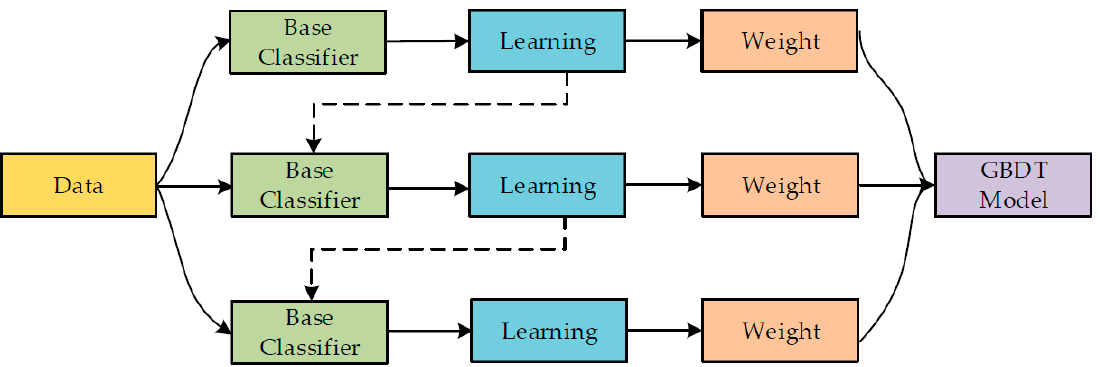
Figure 3. Sequence of gradient boosting regressor training procedure [56].